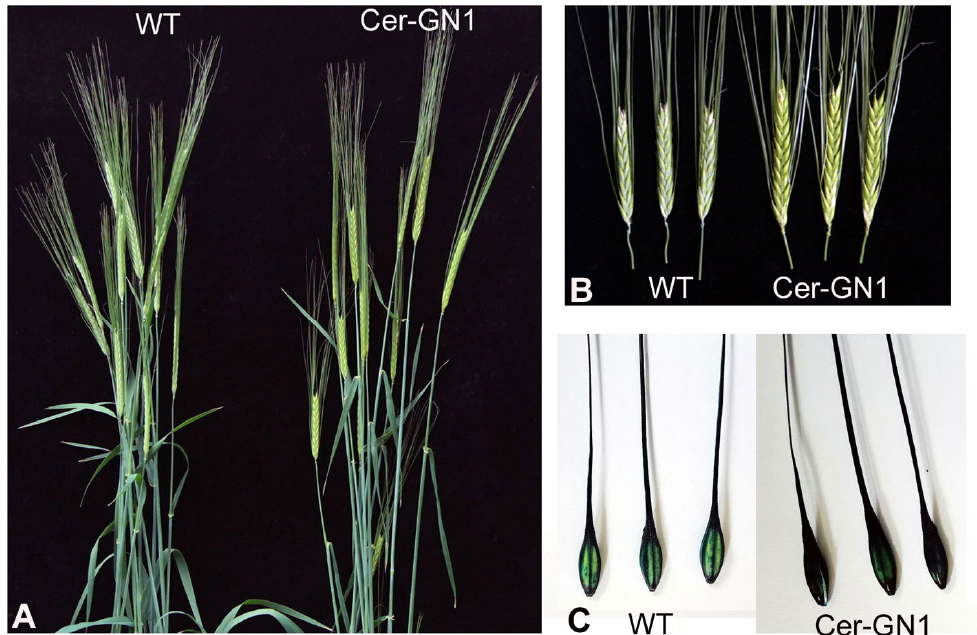
Figure 1. The phenotypes of Cer-GN1 mutant and WT plants. Plants at the grain filling stage ( A ). The cuticular wax phenotype on the spikes ( B ). TB staining of the glume surface ( C ).